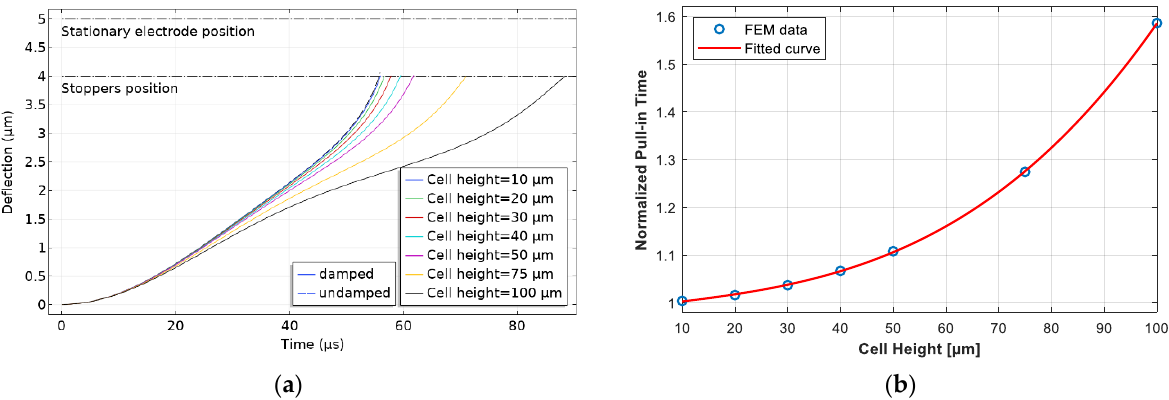
Figure 9. Transient parametric analysis of the pull-in time under both the damped and undamped regimes: ( a ) the deflection response of the AUC with a sweep of the cell height h ; and ( b ) the corresponding pull-in time as a function of the cell height, where the time is normalized to the pull-in time of the undamped condition (55.75 µs).